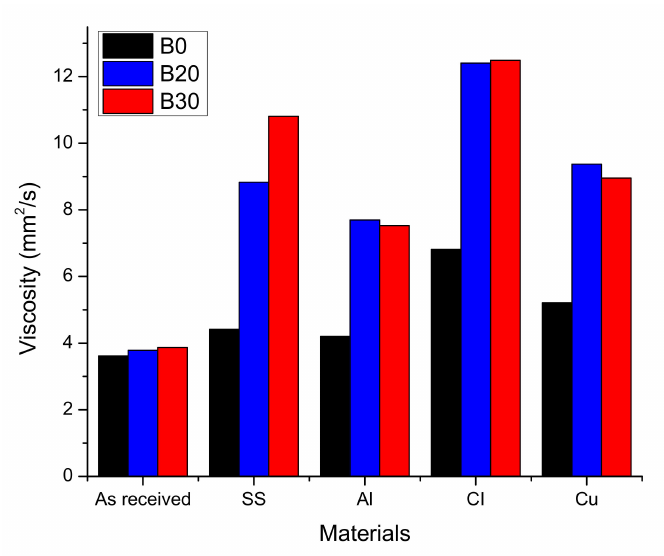
Figure 7. Change in viscosity of biodiesel after the immersion test with different materials.